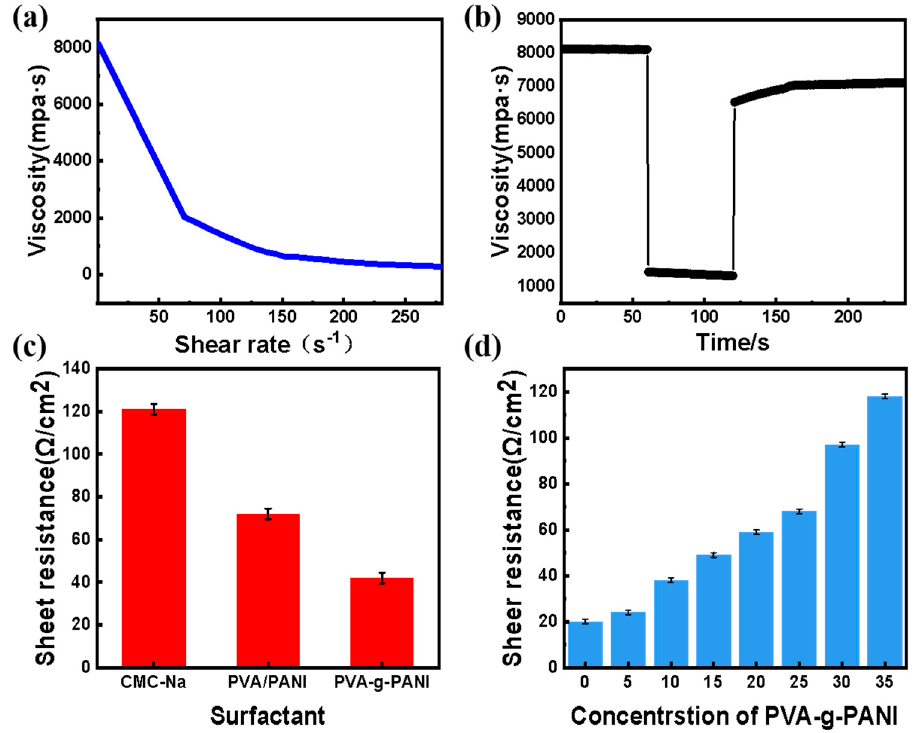
Figure 6. ( a ) Viscosity as a function of shear rate for the graphene/PVA-g-PANI ink, ( b ) graphene/PVA-g-PANI ink rheological behavior during simulation of screen printing, ( c ) sheet resistance of graphene ink with different surfactants, and ( d ) sheet resistance of graphene ink with different concentrations of PVA-g-PANI.